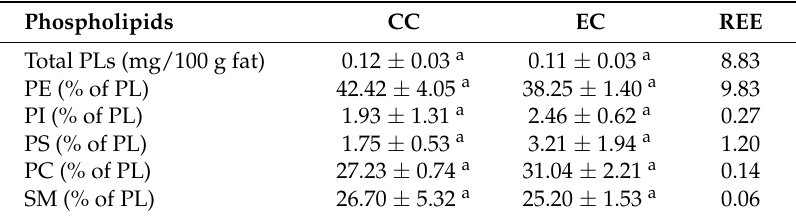
Table 4. Phospholipids composition of the control and the experimental Manchego cheese by the effect of the β